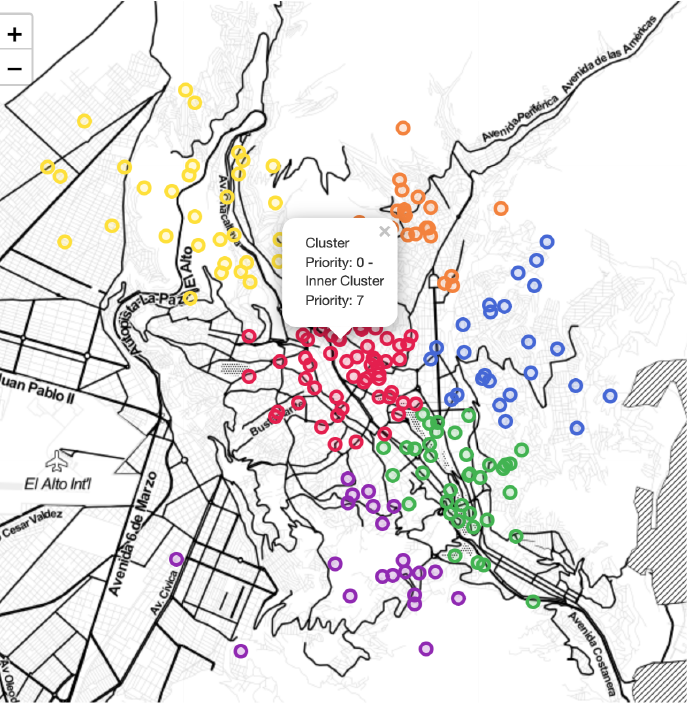
Figure 6. Example of repair request clustering and prioritisation using k-means and k-Nearest Neighbours